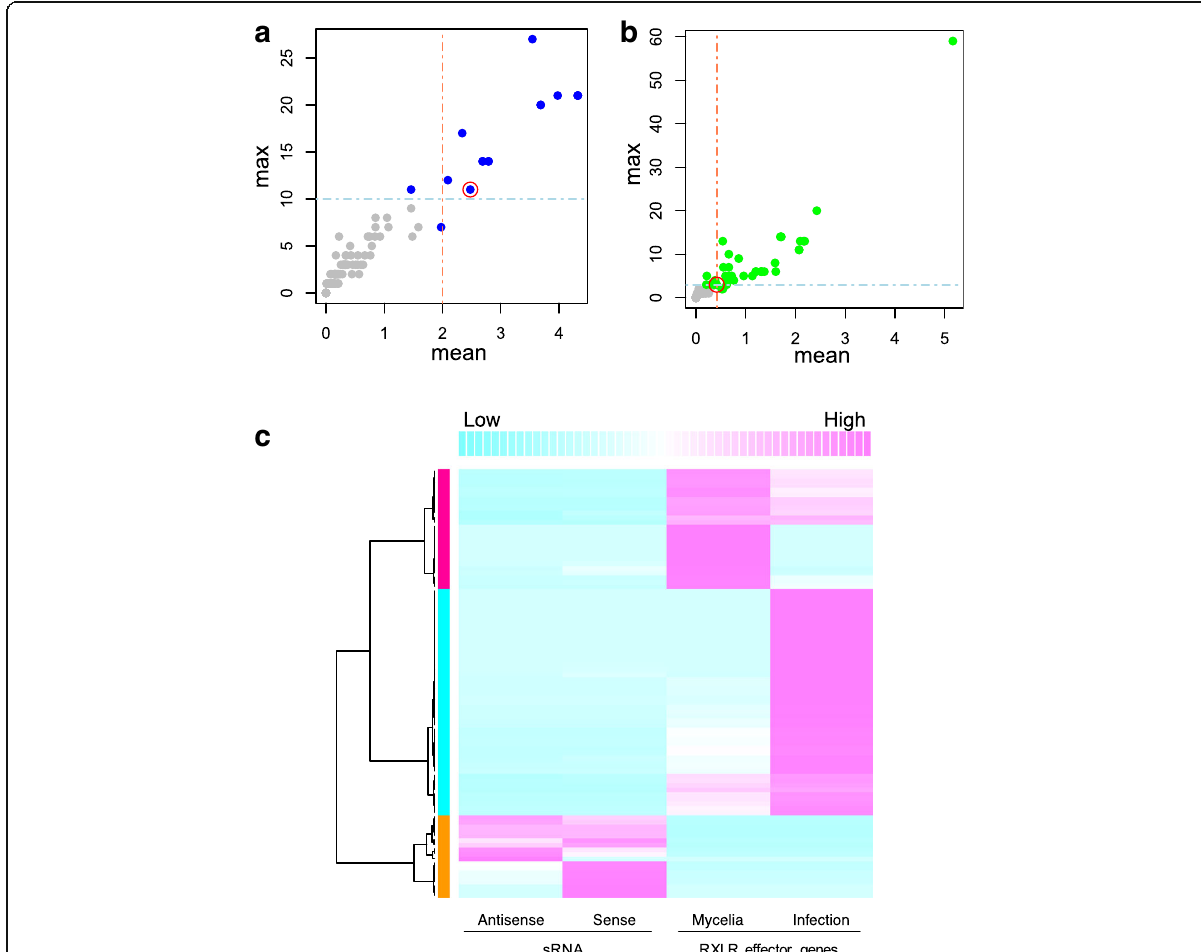
Fig. 5 The expression of numerous RXLR effector genes was negatively associated with the accumulation of homologous sRNAs in P. sojae . Screening of the high confident sRNA-associated RXLR effector genes by sense sRNA level ( a ) and antisense sRNA level ( b ). In a and b , RXLR effector genes having comparable (or more) sRNA reads than the mean (x-axis) or max (y-axis) number of Avr1b sRNA reads homologous to the ORF region were regarded as high confident sRNA associated. Blue or green dots indicate the RXLR effector genes above the threshold. Dashed lines indicate the threshold levels for the mean or max number of reads, and the red circle indicates Avr1b . c The sRNA expression was associated with silencing of RXLR effector genes in P. sojae in mycelia and during infection. The average abundance of sense and antisense sRNA reads of the RXLR effector genes, and the expression level of the RXLR effector genes in mycelia and infection tissues (24h post inoculation) which retrieved from Phytophthora transcriptome database were used for clustering